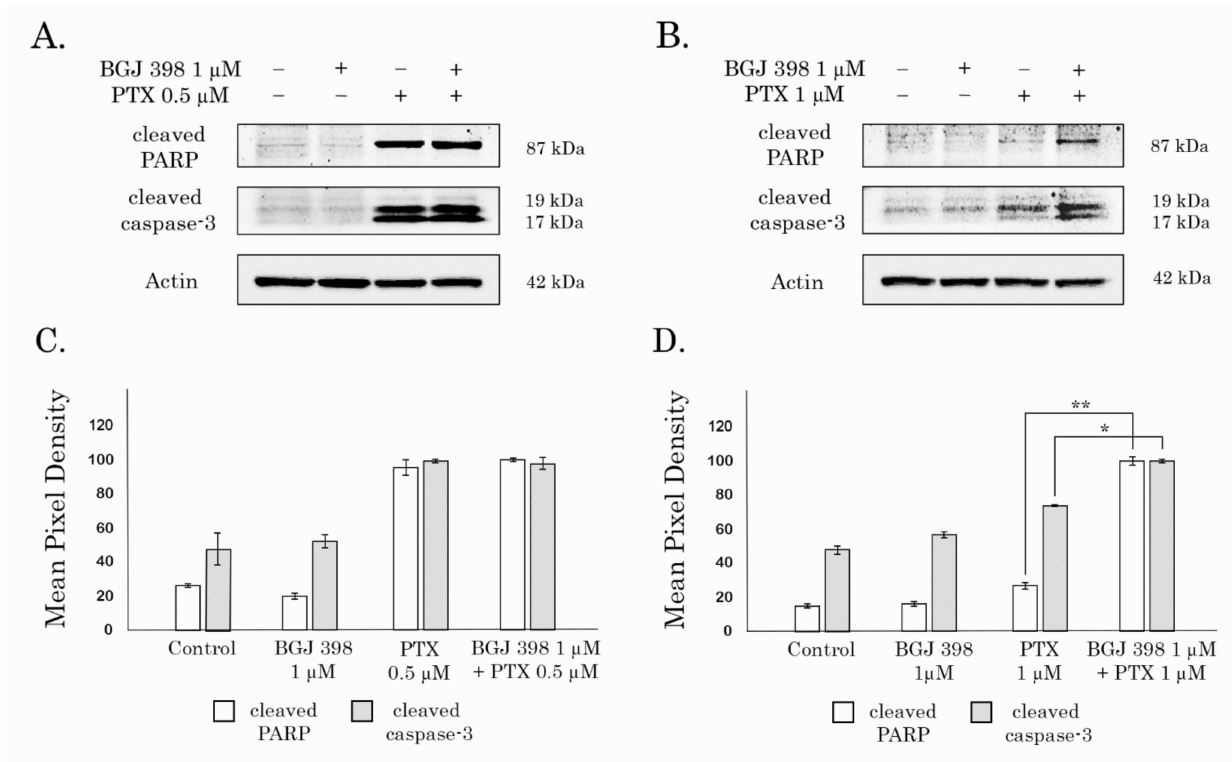
Figure 6. BGJ 398 potentiates apoptosis of Tx-R HCC 1806 cells treated with combination of PTX. Immunoblot analysis for apoptosis markers (cleaved forms of PARP and caspase-3) in naive ( A ) and Tx-R ( B ) HCC1 806 breast cancer cells after treatment with DMSO (negative control), PTX, BGJ 398 alone or in combination for 48 h. Actin stain is used as a loading control. ( C , D ) Quantification by mean pixel density in the cleaved forms of PARP and caspase-3 in naive ( C ) and Tx-R ( D ) HCC 1806 breast cancer cells. Values are means ± SD, n = 3. * p < 0.05, ** p <